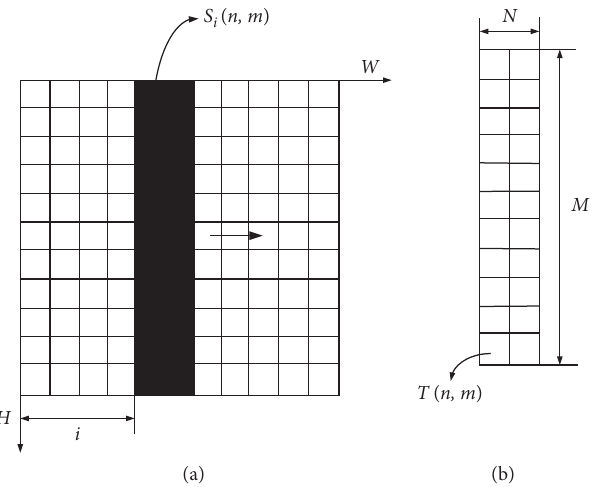
Figure 3: Schematic diagram of template matching in horizontal direction. (a) Searched image S S ( W , H ). (b) Template image T T ( N , M